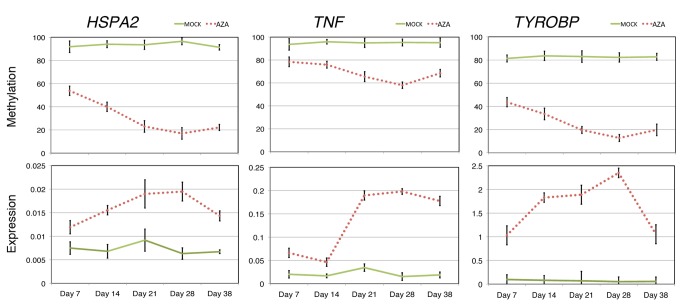
Time-course methylation and expression analysis for HSPA2, TNF, and TYROBP in AZA treated SKM-1 cells.
Top, CG methylation as determined by pyrosequencing. Y-axes indicate mean percentage of methylation at 3 (HSPA2), 5 (TNF), and 4 CpG sites (TYROBP). Bottom, qRT-PCR data showing relative gene expression normalized to the housekeeping gene GAPDH. No drug was applied to the cells from day 28 to day 38. Both expression and methylation data are means (± SEM) from four independent experiments obtained from mock- (green line) and AZA- (red dashed line) treated cells.